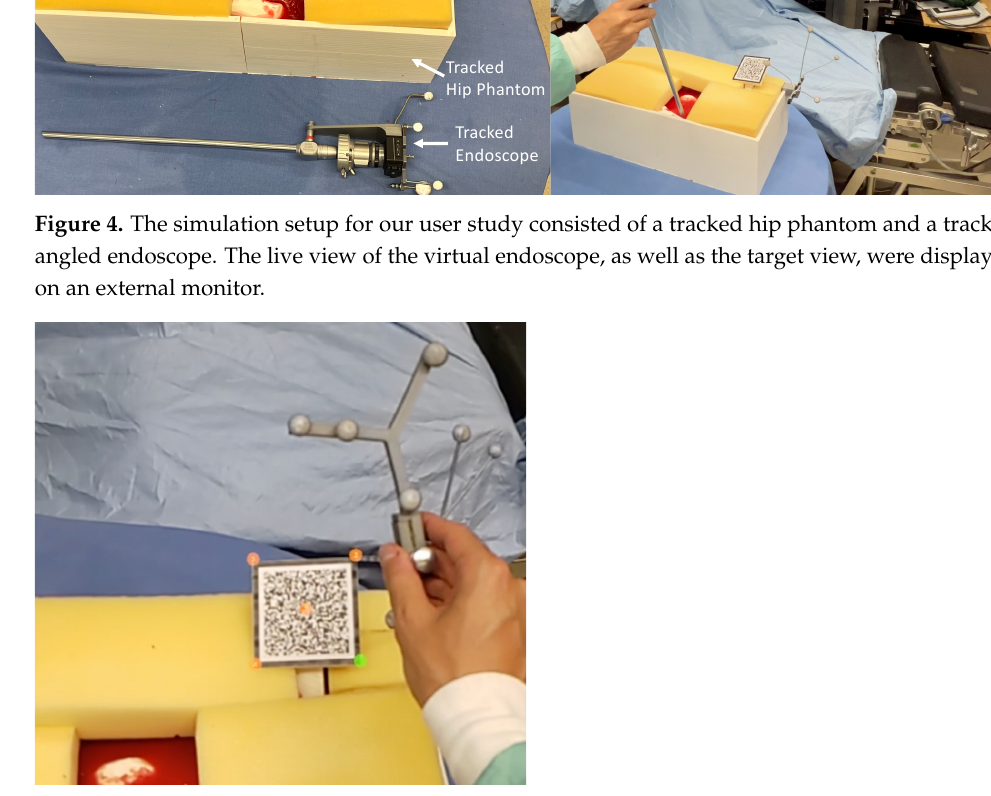
Figure 5. Calibration procedure between HMD and NDI tracking